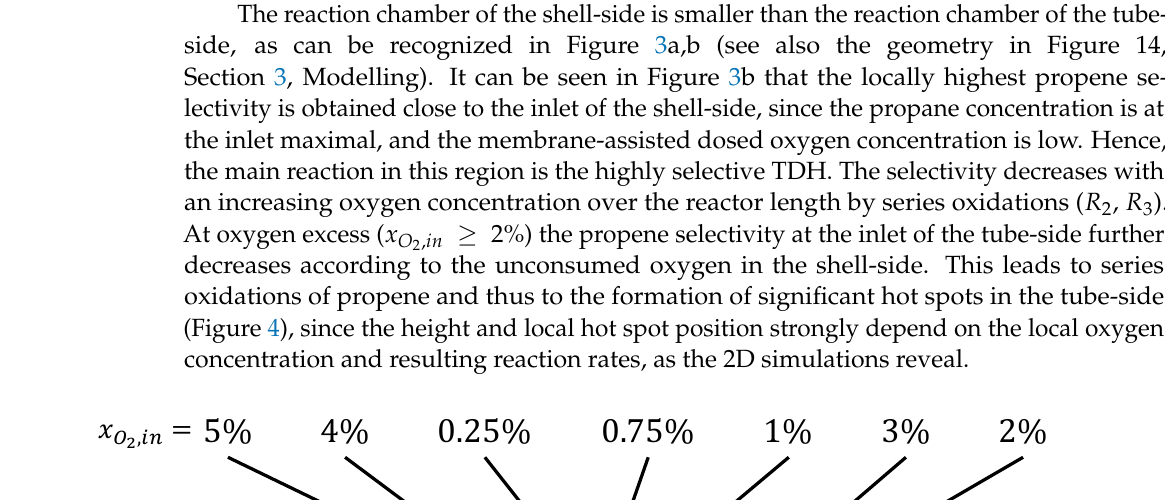
Figure 4. Hot spot positions in the PBMRint in dependency of the inlet concentration of oxygen ( x C = 0.25%…5%; T W = T in = 600 °C; WHSV = 400 kg ⋅ s ⋅ m -3 ). x O 2 ,in